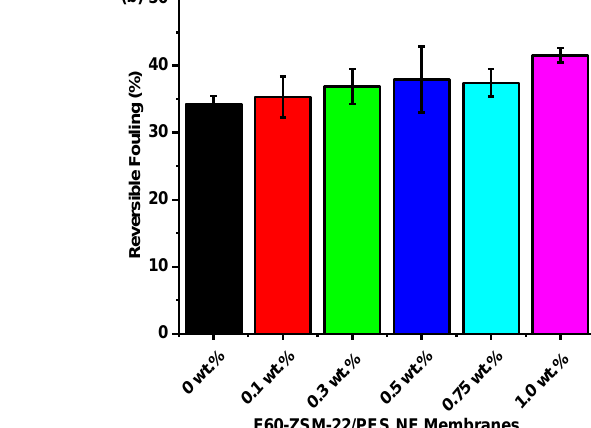
Figure 12. Total fouling analysis of nanofiltration membranes prepared via phase inversion to nominal wt.% loadings of 0, 0.1, 0.3, 0.5, 0.75, and 1.0 using ZSM-22 zeolite as nanoadditives: ( a ) C60-ZSM-22/PES and ( b ) F60-ZSM-22/PES. As shown in Figure 12, the results further indicate that the C60-ZSM-22/PES and F60-ZSM-22/PES NF composite membranes have better antifouling performance than the pure PES membranes. The high total fouling exhibited by the pure PES membrane evidenced this. It is interesting to note that the total fouling exhibited by C60-ZSM-22/PES and F60-ZSM-22/PES decreased with increasing zeolite wt.% loading. Zeolite loadings of 1.0 wt.% for both C60-ZSM-/PES and F60-ZSM-22/PES NF attained lower total fouling of 63 and 64%, respectively. The following reversible fouling graphs for C60-ZSM-22/PES and F60-ZSM-22/PES are shown in Figure 13.